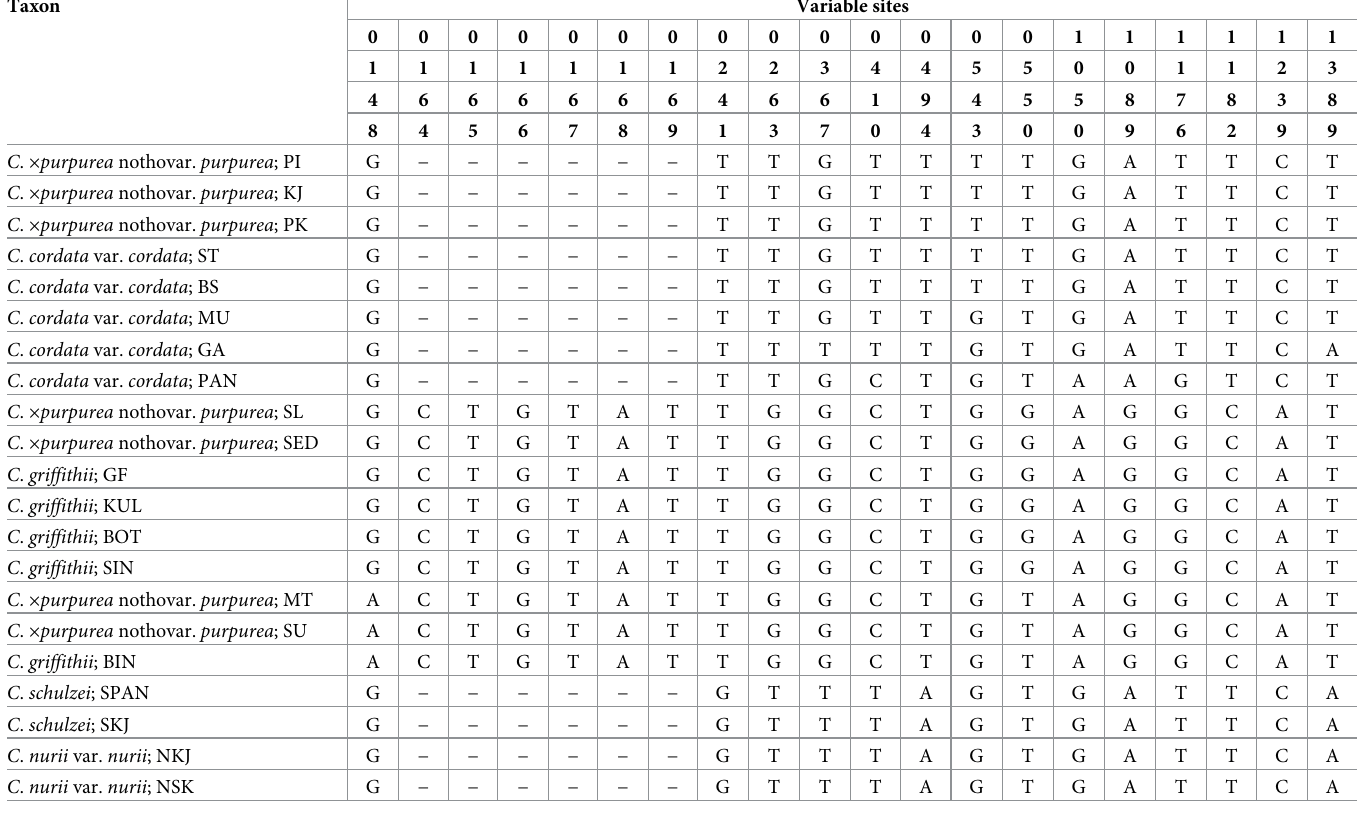
Table 3. Variable nucleotide sites of trn K -mat K sequences’ comparison of C . × purpurea nothovar. purpurea and the putative maternal parents.